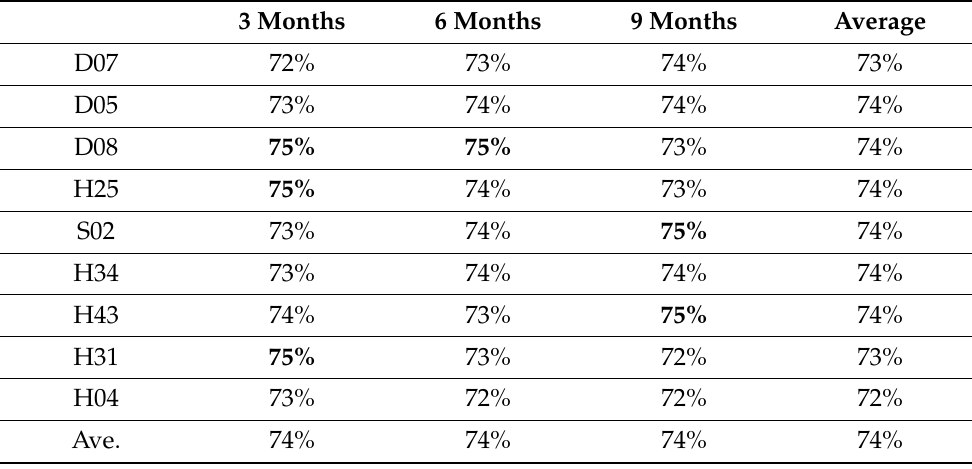
Table 4. Simulation experiment result: planned maintenance to each equipment (duration: 12 h).